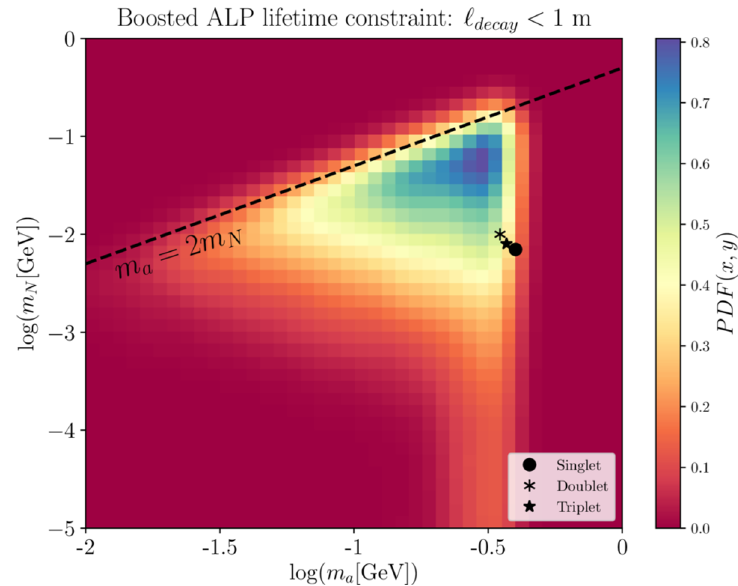
Figure 4 . Points in the plane of masses m a versus m N which satisfy eqs. (3.7) and (3.9). The points where randomly generated for the parameters in the same intervals of eq. (4.1). The dot, asterisk and star represent examples of a singlet, doublet and triplet representation of the UV complete model presented in section 5,